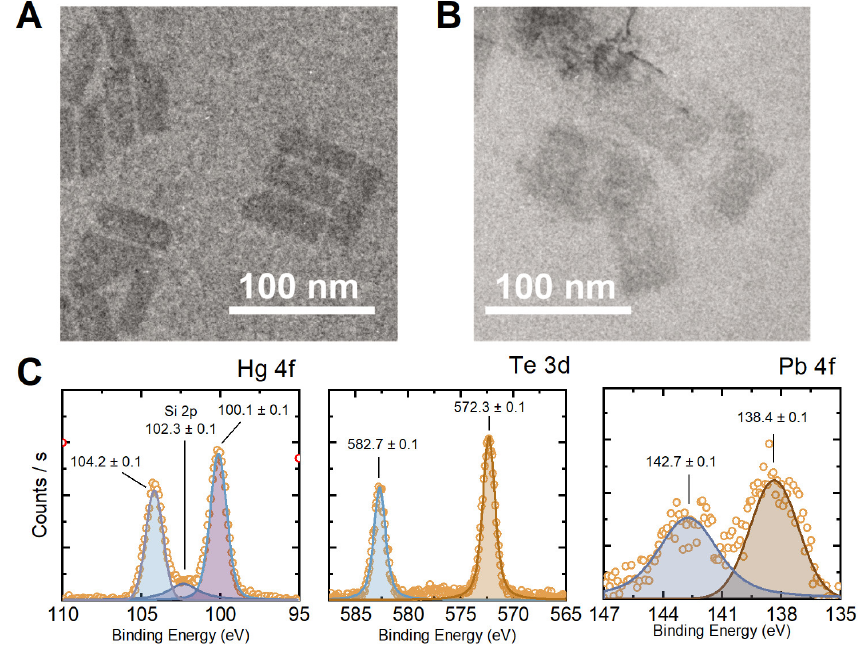
Figure 2. ( A , B )—TEM images of the HgTe and 4% Pb-dopped HgTe NPLs, respectively. ( C )—High- resolution XPS spectra taken from HgTe:Pb 4% for Hg, Te and Pb elements.